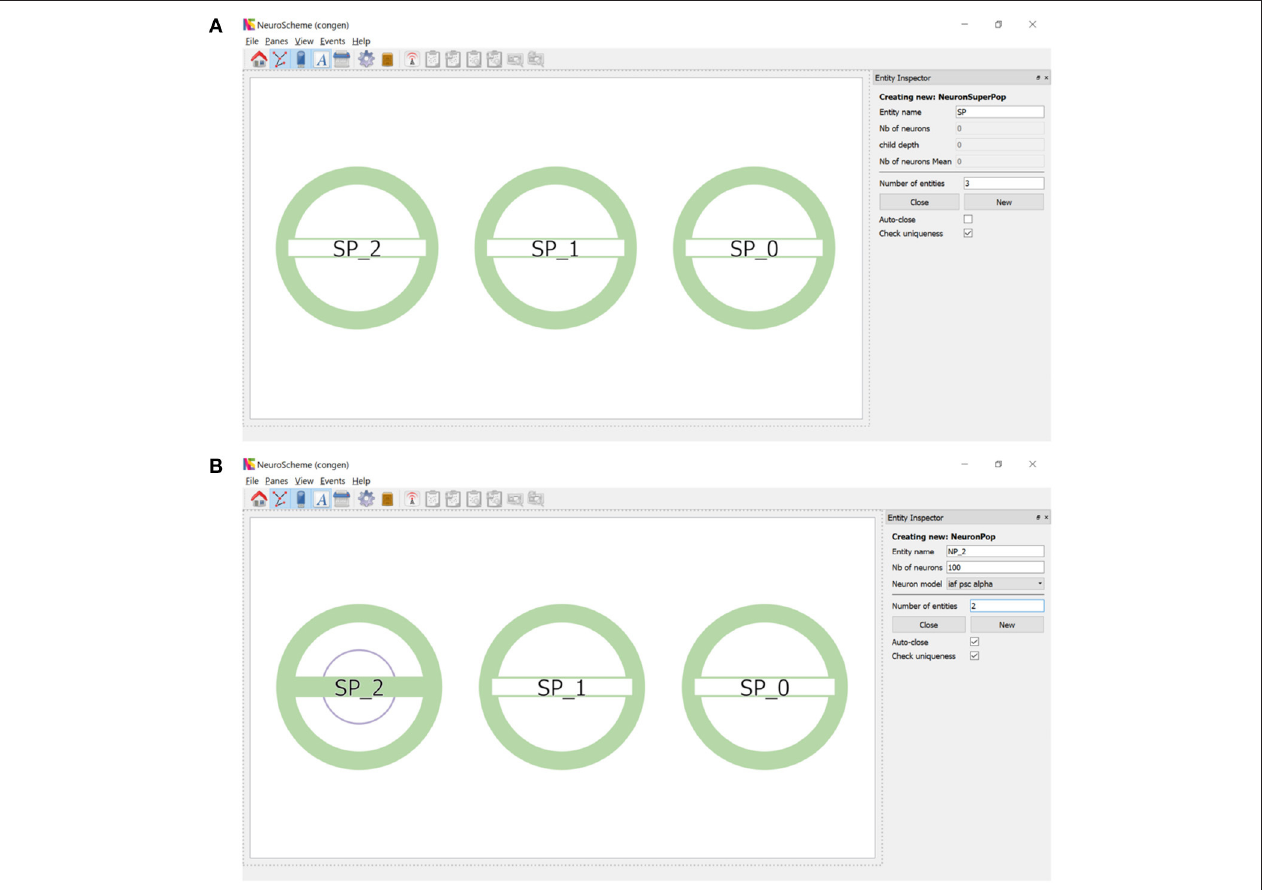
FIGURE 2 | Creation of super-populations and populations. (A) The panel on the right sets the name root of the super-populations (SP in this example) and the number of entities (three in this example) to be created. (B) Right clicking on SP_2 allows the creation of descendant neuron populations. The panel on the right sets the name root of the populations (NP_2 in this example) and the number of entities (two in this example) to be